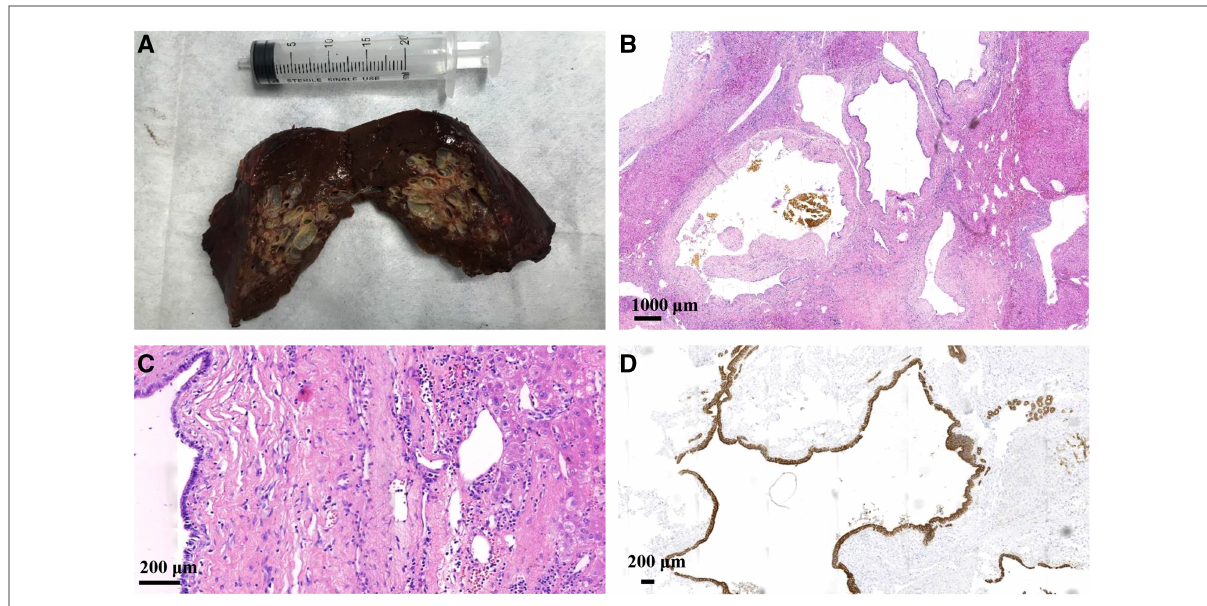
FIGURE 3 The surgical specimen ( A ) shows a nodular mass with a gray-white honeycomb-like cystic-solid lesion observed in one section. Hematoxylin and eosin staining under ( B ) low-power microscopy displaying cystically dilated ductal and irregularly angulated structures along with bile-stained materials observed in some ducts, and ( C ) high-power microscopy showing that the ductal epithelium is composed of monolayered columnar and cuboidal epithelium. Normal hepatocytes are observed between the cystic ducts. ( D ) Immunohistochemistry showing CK7 and CK19 positivity in the dilated duct